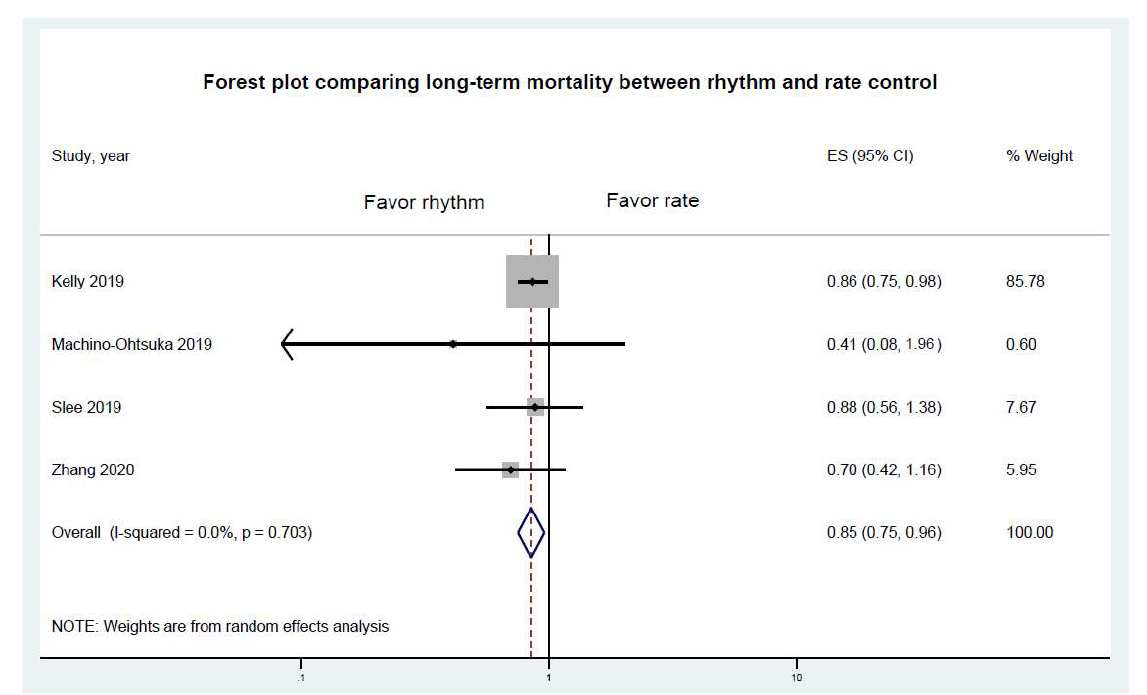
Figure 2. Forest plot comparing risk of long-term mortality between rhythm and rate controls. Horizontal lines represent the 95% CIs, with marker size reflecting the statistical weight of the study, using the random-effects model. A diamond data marker represents the overall adjusted OR and 95% CI for the outcome of interest.